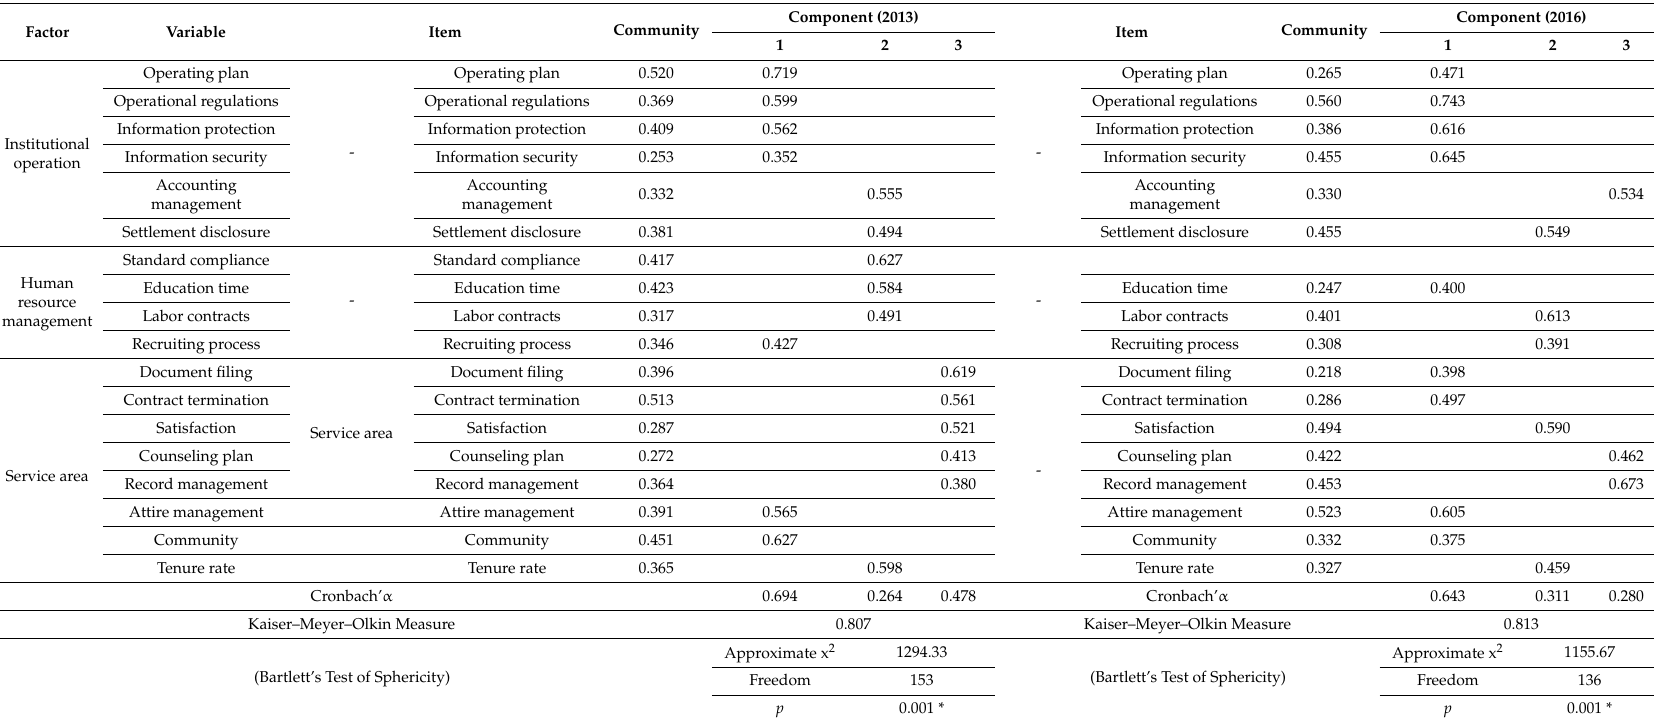
Table 4. Common indexes for QE of social services (2013 and